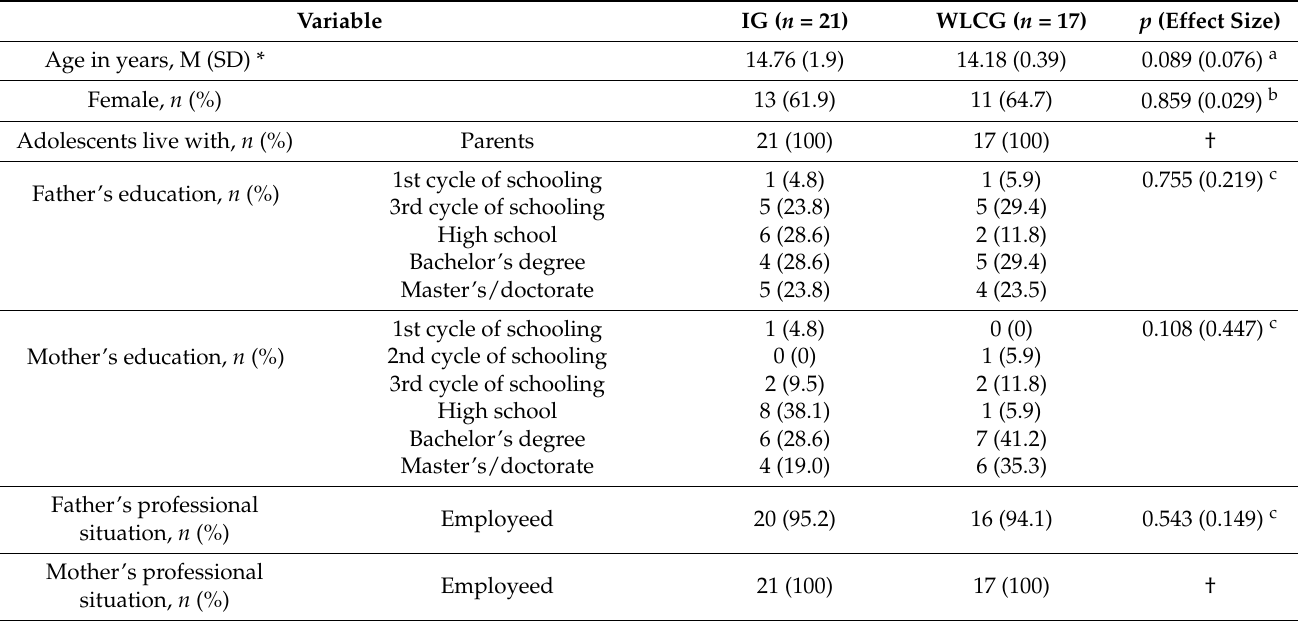
Table 1. Participants’ sociodemographic characteristics in the baseline ( N = 38).